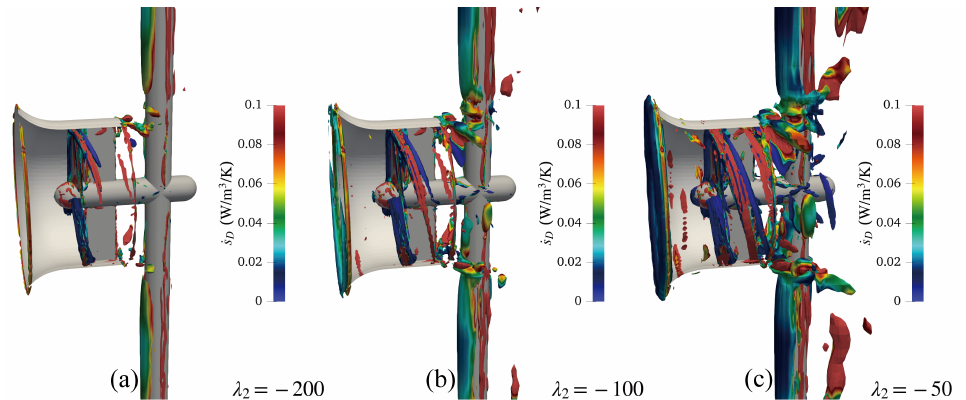
Figure 11. Vortical structure of the turbine, isosurfaced by different λ 2 ( TSR = 3.6 ) .